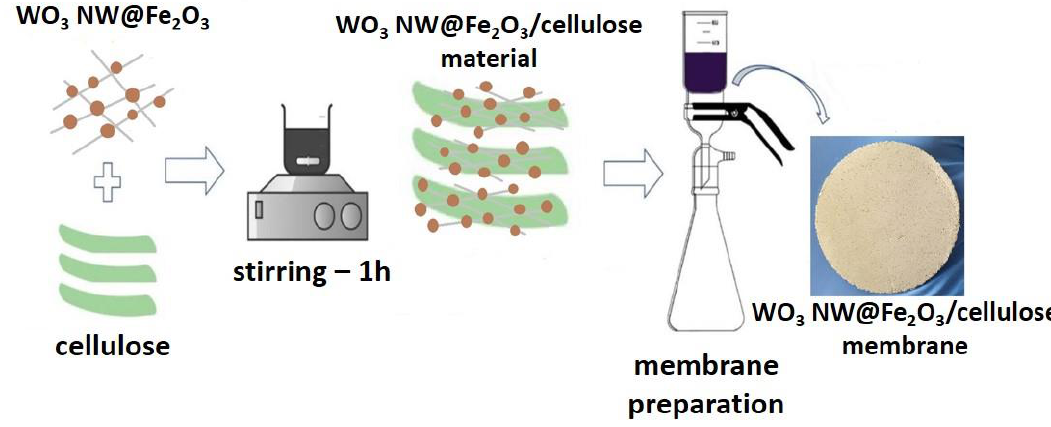
Figure 7. Schematic illustration of the process of hybrid membrane preparation.